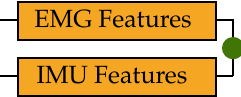
Figure 8. Testing flow for the classification methods during each cross-validation iteration using both EMG and IMU data. A similar procedure was used for the EMG only dataset. Data from Subject S n in the cross-validation testing fold (orange) are normalized and reduced to form a new dataset X Data . The green dots represent a feature-level fusion.